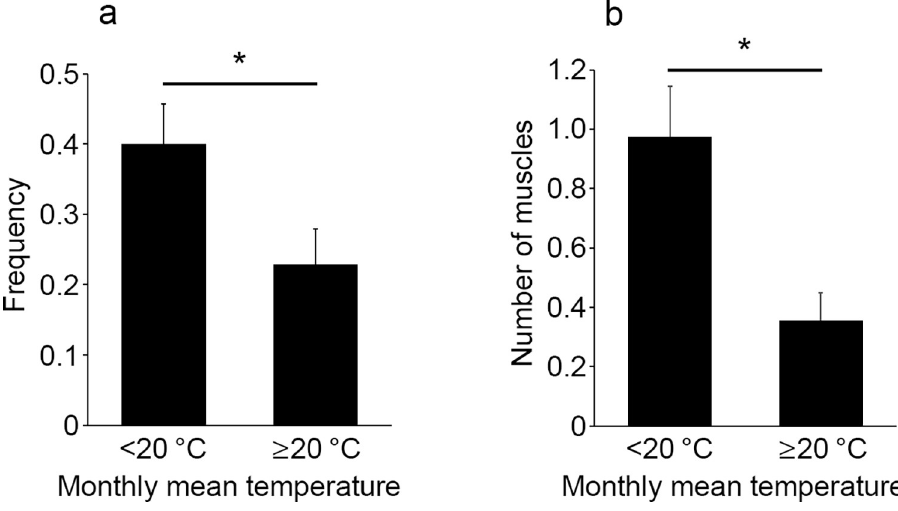
Fig 6. Comparison of the frequency of intramuscular hemorrhage (a) and the number of muscles with hemorrhage (b) between monthly mean temperature below 20˚C and monthly mean temperature above 20˚C. All values represent the mean ± SEM. � p <